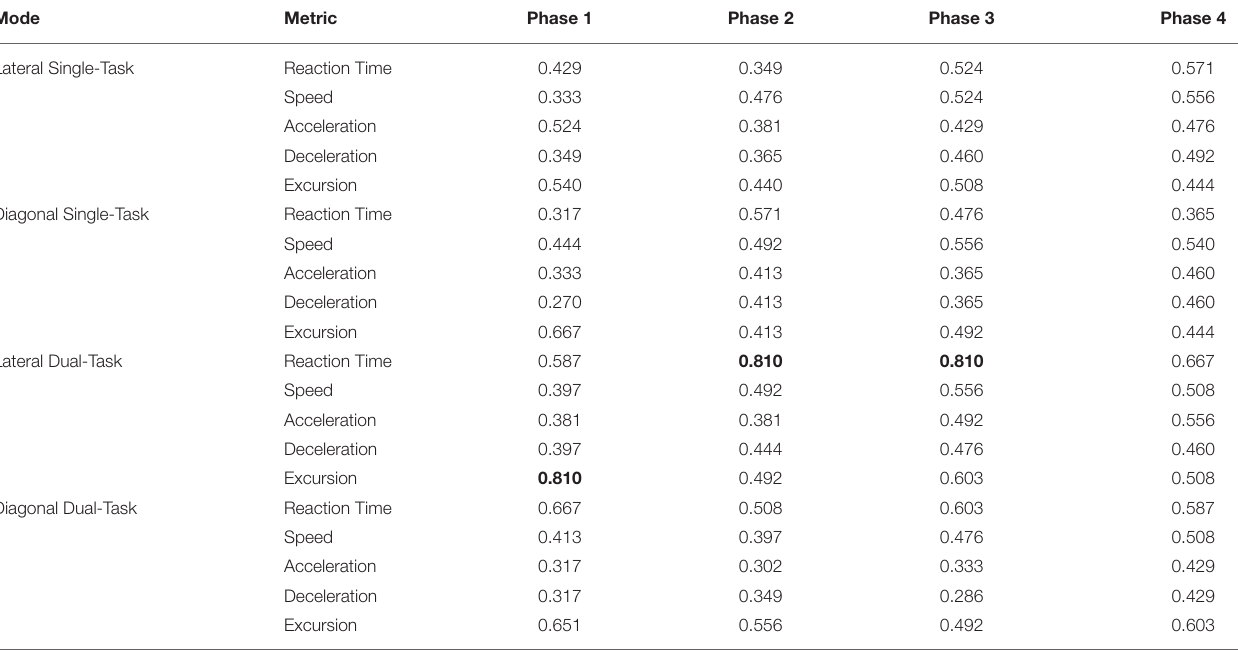
TABLE 3 | Receiver operating characteristic area under curve values for Average * of performance metrics for each task mode. Mode